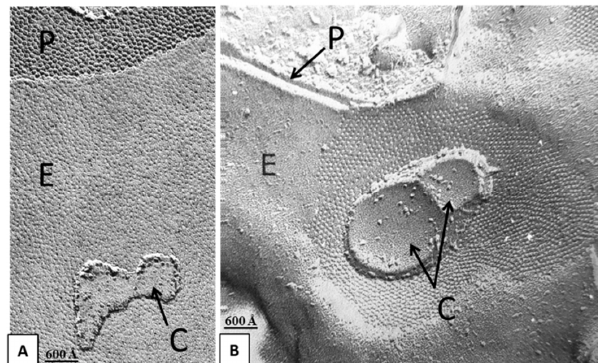
Figure 3. Freeze-fracture images of gap junctions between rat liver ( A ) and stomach ( B ) epithelial cells showing membranes of cytoplasmic cisterns ( C ) apparently attached to gap junction membranes. P, Protoplasmic face; E, Exoplasmic face. A from [18]; B from [17].